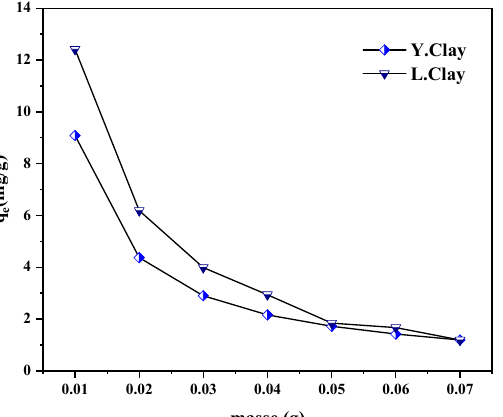
Figure 5. Effect of adsorbent dose; Conditions: t = 10 min for Y. Clay/15 min for L. Clay, C = 12 mg/L,